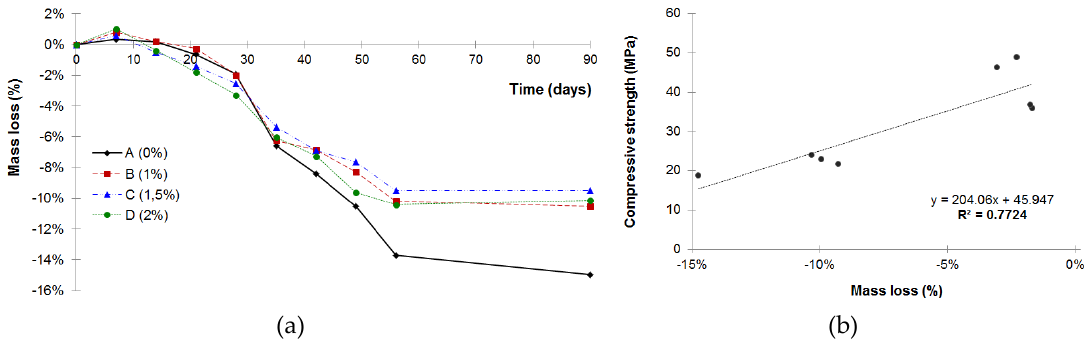
Figure 4. ( a ) Mass loss due to the sulphuric acid attack. ( b ) Correlation between compressive strength (MPa) and mass loss (%) after the acid attack.